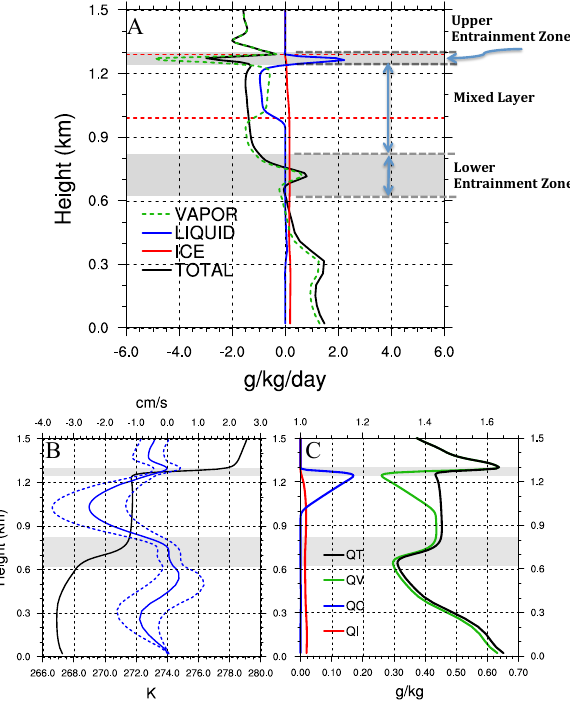
Fig. 11. Tendencies averaged over the square box calculated from 15-min averages. Entrainment zones indicated with gray shading. (A) Cloud water, vapor, ice, and total water tendencies, in units of gkg − 1 day − 1 . Gray dash lines denote boundaries of cloud top en- trainment zone, mixed layer, lower entrainment zone. Positive (neg- ative) indicates water gained (lost) by the layer. Cloud layer top and base indicated by red dashed lines. (B) Mean resolved vertical ve- locity (blue, dash lines are ± one standard deviation) and equivalent potential temperature in black, in units of cms − 1 and K, respec- tively. (C) Mean total water, cloud liquid water, cloud ice water, and water vapor, in units of gkg − 1 . Note that the cloud layer is primarily in the mixed layer and extends approximately 50m into the upper entrainment